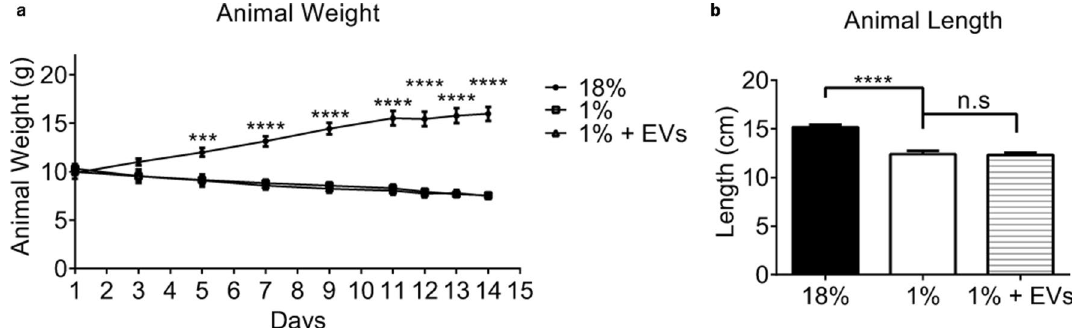
Figure 2. Impact of malnutrition and milk EV treatment on body measures of mice. ( a ) Body weight of sham- treated mice fed 1% protein diet was significantly lower at day 14 when compared to controls i.e. sham-treated mice fed 18% protein diet (n = 7, P < 0.0001). The body weights of milk EV-treated mice fed 1% protein diet did not improve compared to sham-treated mice fed 1% protein diet (n = 7, P = 0.72). ( b ) The body length at day